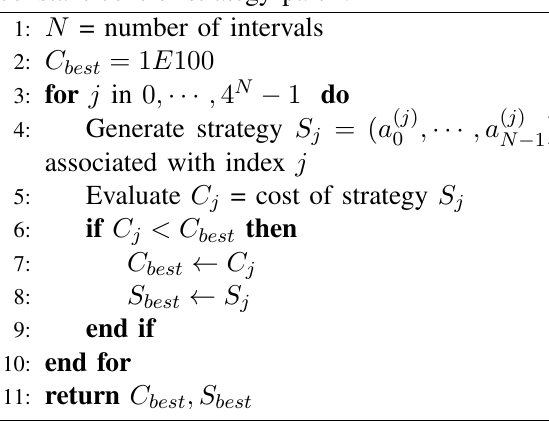
Algorithm 1 Calculation of optimal